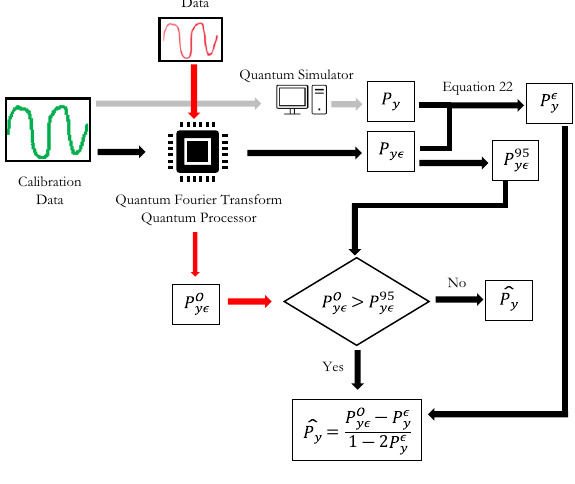
Figure 11. Flow chart of method to estimate probabilities using